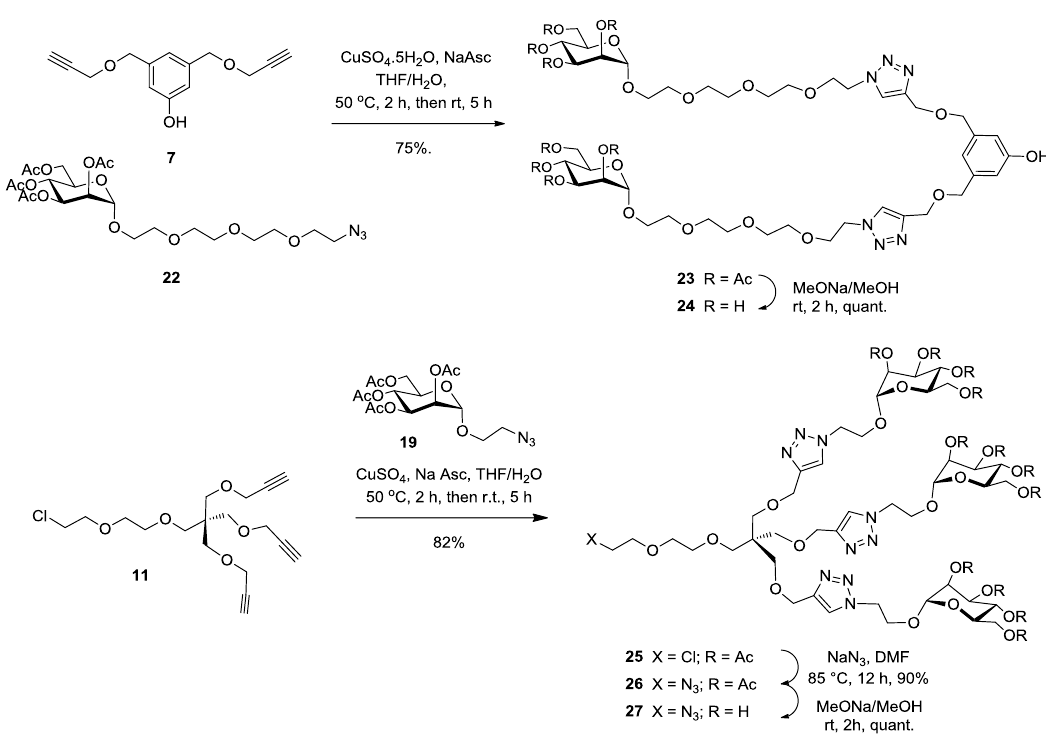
Scheme 5. Synthesis of dimeric ( 24 ) and trimeric ( 27 ) mannodendrons using click chemistry.